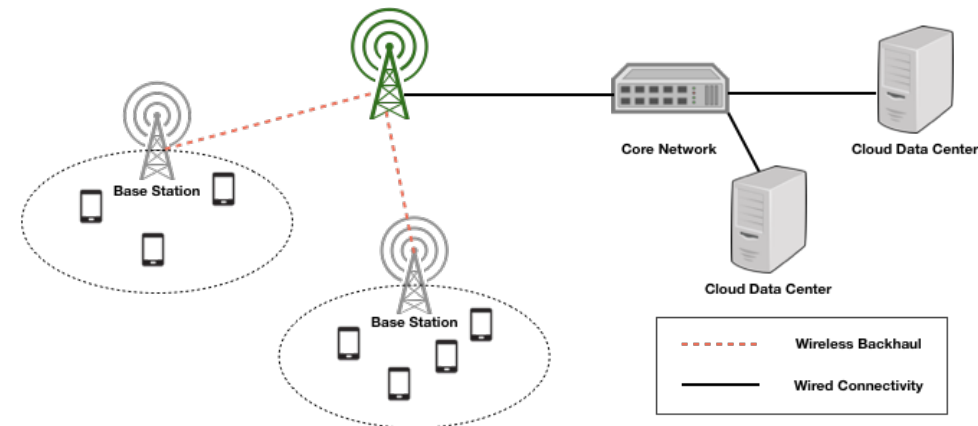
Figure 1. The existing cloud computing